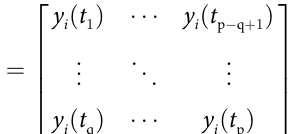
S1 Fig. Thermotactic behavior is reproduced by a variety of neuroanatomical models. (A) 32 independent parameter sets having a fitness score of at least 0.5, including 8 parameter sets having a fitness score of at least 0.6 (B) are plotted in parameter spaces as black dots and red dots, respectively. The parameter subspaces are the space defined by principal components of 6 bias terms that shift sensitivity range of inter- and motor neurons (leftmost panel), the space defined by principal components of 12 connection weights of chemical/electrical synapses (second left panel), the plane defined by a connection weight from a pattern generator to motor neurons and a connection weight of neuromuscular junction (second right panel), and the space defined by 3 terms that determine response property of a thermosensory neuron (rightmost panel). Individual parameter sets were assigned numbers (#) from 1 to 200. For the 8 good models, the circuit diagram (C) , the time course of TTX index, and the profile of curv- ing bias (D) are plotted. In the circuit diagrams, thickness of each connection is represented proportionally to its connection weight. All the 8 models reproduced empirical impairments of curving bias upon ablating individual interneurons AIB, AIY, and AIZ (E) .